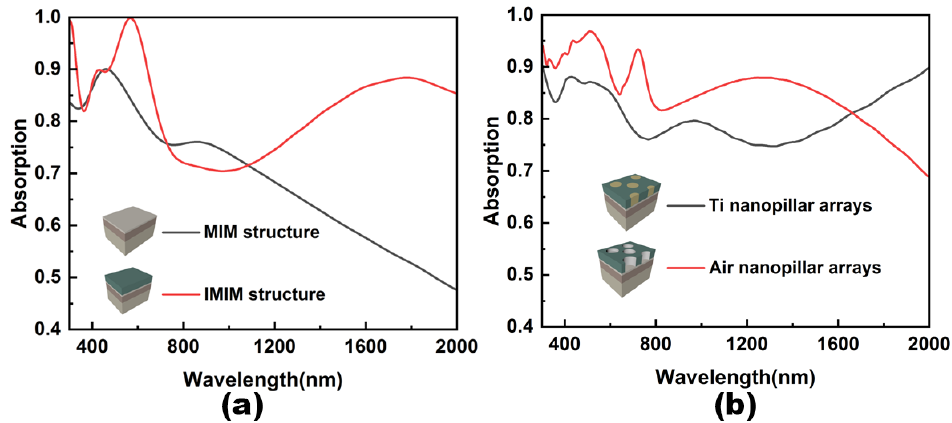
Figure 3. Absorptive spectra of different structures. ( a ) Absorptive spectra of MIM structure and IMIM structure. ( b ) Absorptive spectra of IMIM structure with Ti and air nanopillar arrays.